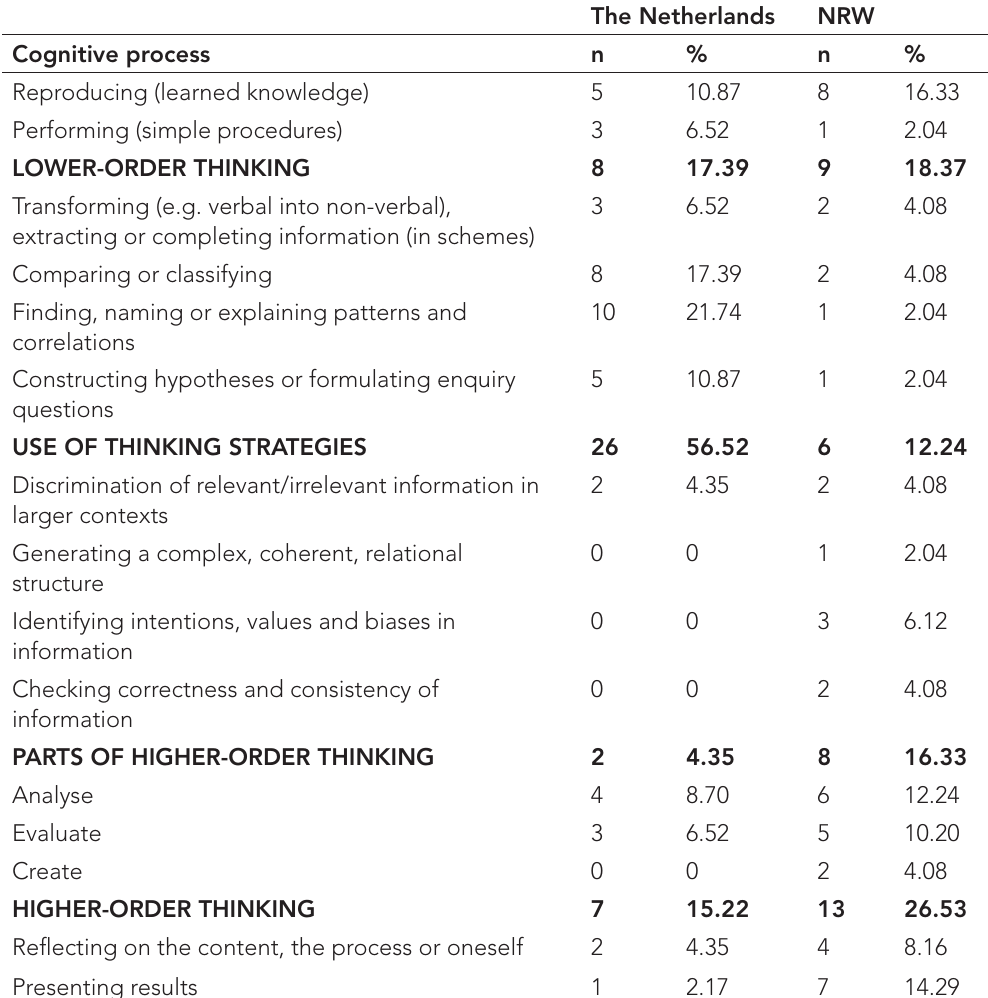
The Netherlands NRW